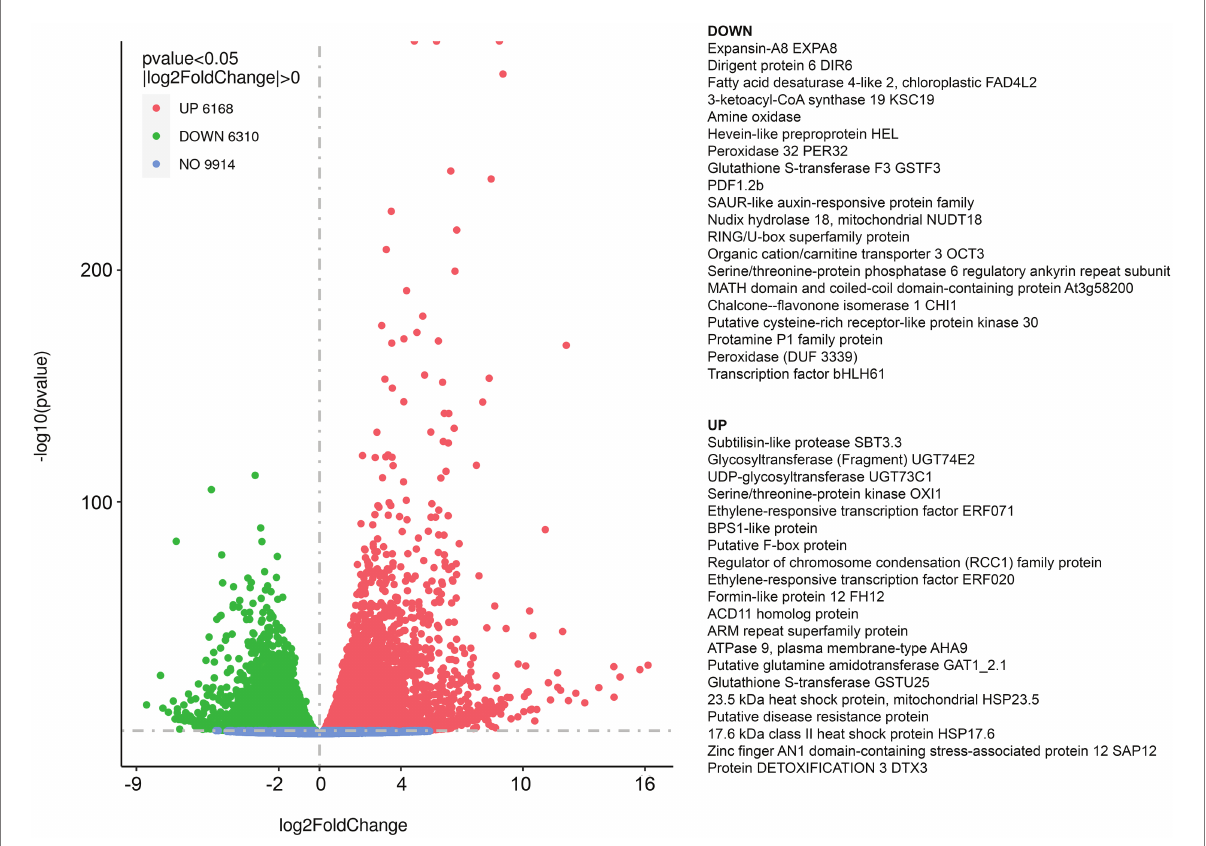
FIGURE 1 Summary of the RNA-seq results and differentially expressed genes (DEG) in response to diethyl ether anesthesia in Arabidopsis thaliana . Volcano plot representation of differential expression analysis of genes in the control vs . diethyl ether treated plants. Green and red points mark the genes with significantly decreased or increased expression, respectively in diethyl ether treated plants compared to controls ( p < 0.05). Blue points mark the genes that are not significantly differentially expressed. The x -axis shows log 2 fold changes in expression and the y -axis the log 10 p values of a gene being differentially expressed. On the right, top 20 upregulated and top 20 downregulated genes based on log 2 fold change are listed. The complete list of DEG is available as Supplementary Table